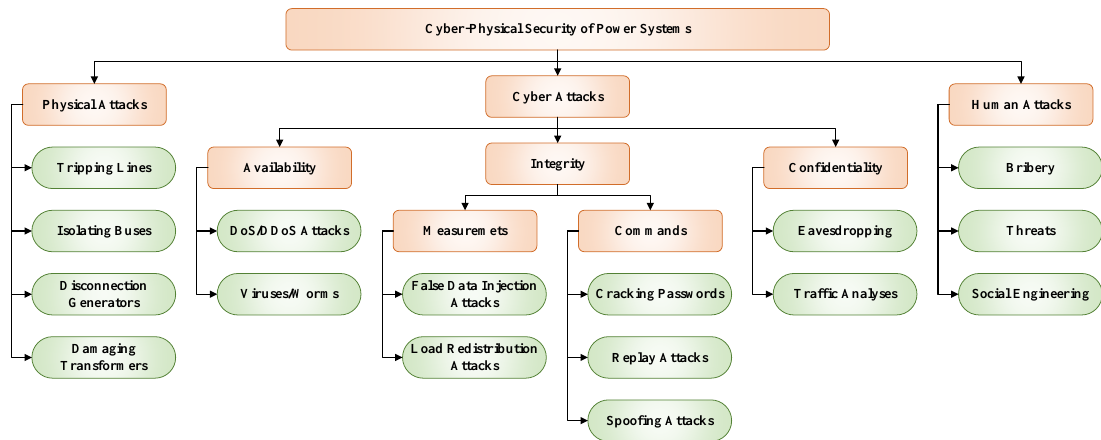
Figure 1. Various types of attacks against the modern power grid